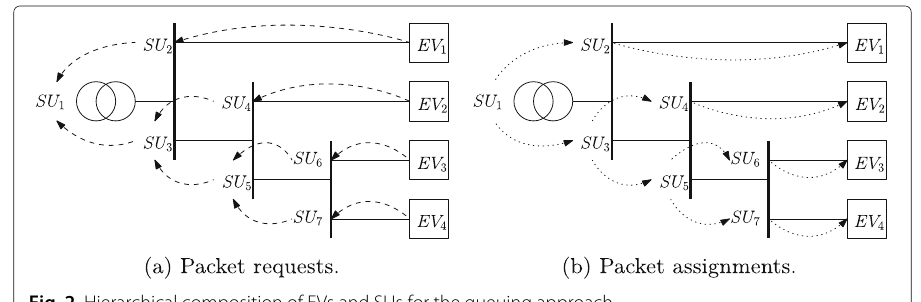
Fig. 2 Hierarchical composition of EVs and SUs for the queuing